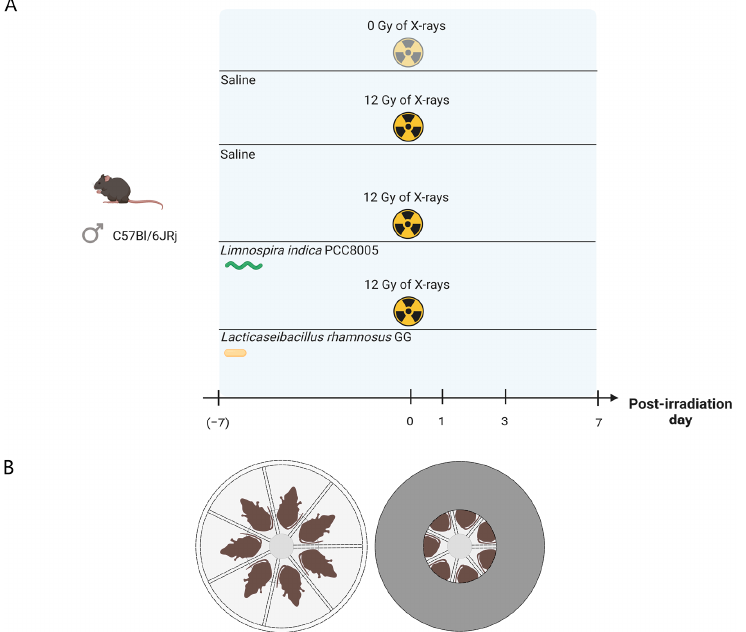
Figure 1. Experimental setup. ( A ) Experimental timeline for supplementation and pelvic irradiation of mice. Supplementation was carried out from seven days prior to pelvic irradiation until the day of sacrifice at either post-irradiation day 1, 3 or 7. Created with BioRender.com. ( B ) Disk-shaped plexiglas box used for local, pelvic irradiation of the mice. Individual animals were placed inside in a prone position ( left ). The entire box, except for the center (9 cm diameter), was shielded with lead (5 mm thick) ( right ). This figure was created with BioRender.com.